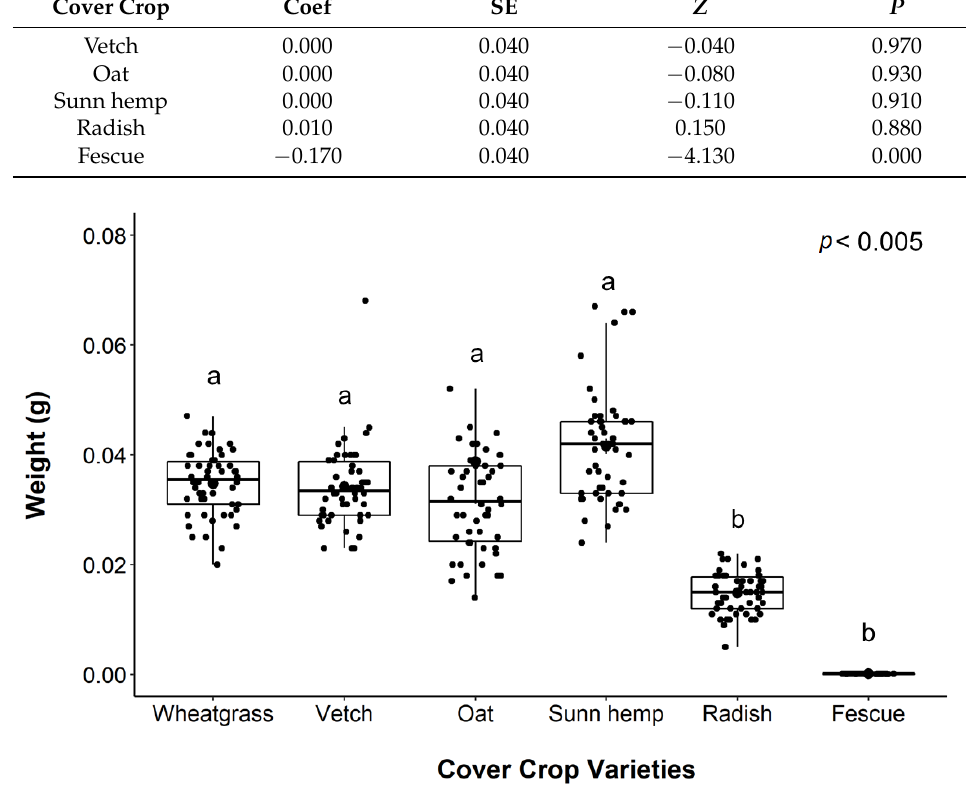
Figure 5. Differences in seed weight among the six cover crop seeds ( n = 50/seed type) used in the study. Boxplots are in the style of Tukey where the box limits represent the lower 25% and upper 75% quantile, with the line representing the median. Tukey HSD was used to determine significant differences (denoted by letters) among seed weights.